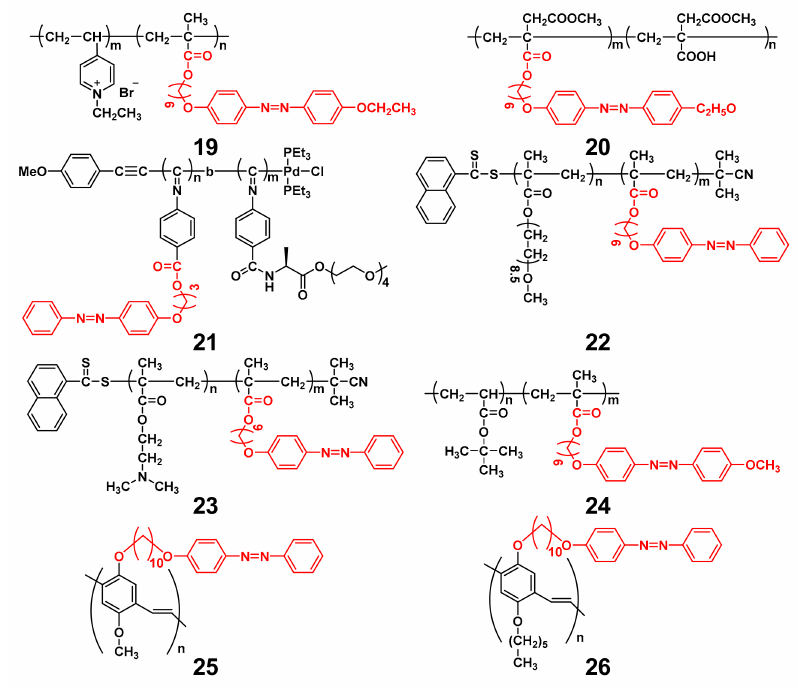
Figure 13. The molecular structure of azobenzene-containing polymers 19 – 26